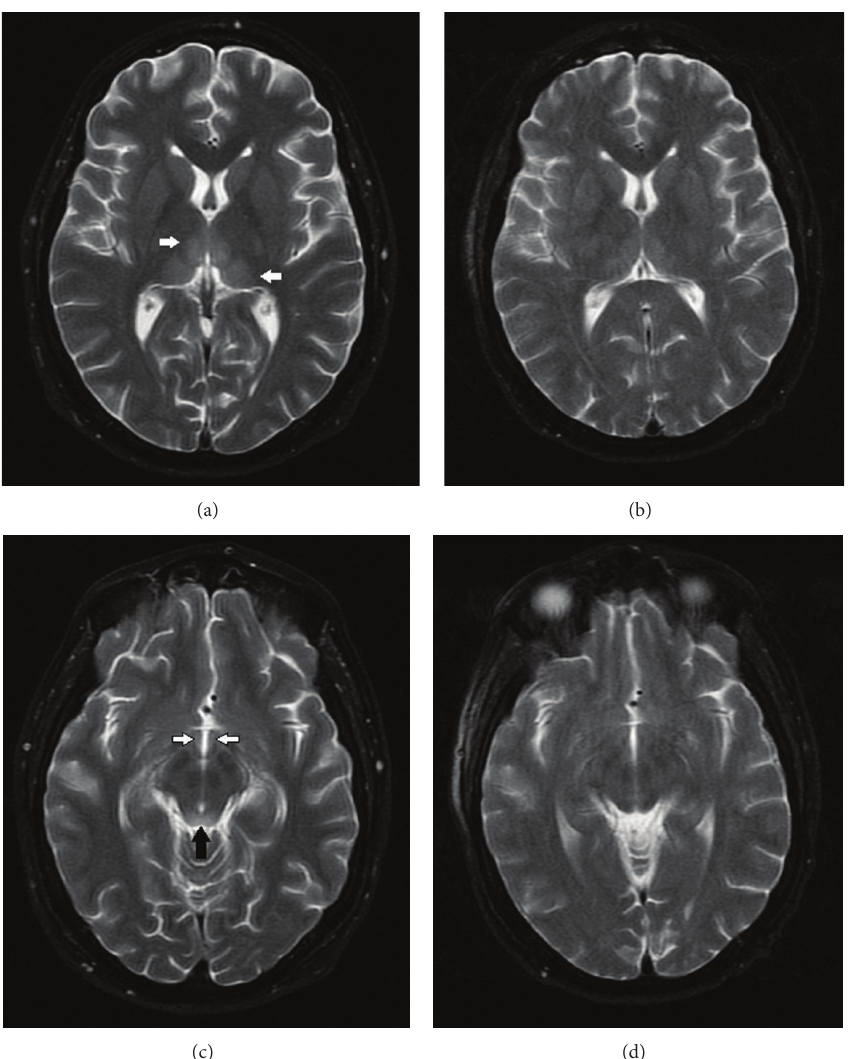
Figure 1: T2 brain MRI one day ((a), (c)) and seven days ((b), (d)) after admission. Signal abnormalities in bilateral thalami ((a), arrows) and interval improvement (b). Signal abnormalities involving the hypothalamus ((c), white arrows), periaqueductal gray matter ((c), black arrows), and interval improvement